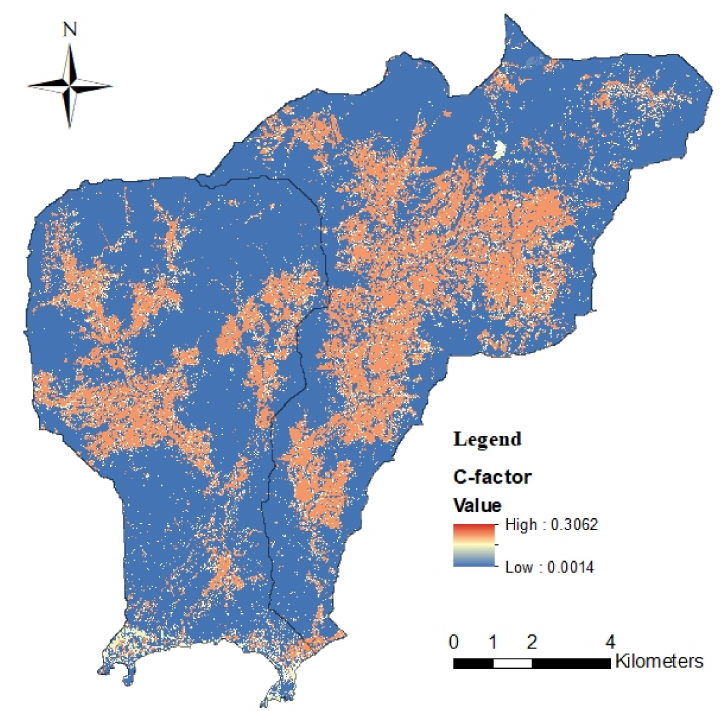
Figure 10. C(literature)-factor